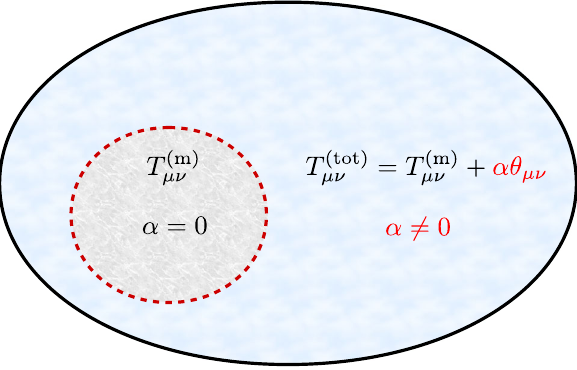
Fig. 1 Any perfect fluid solution can be extended via the MGD approach [16]. When α = 0 we are in the space of isotropic solution of Einstein equations, delimited by the red dashed line. This solution has a smooth extension to the anisotropic domain releasing the α to be